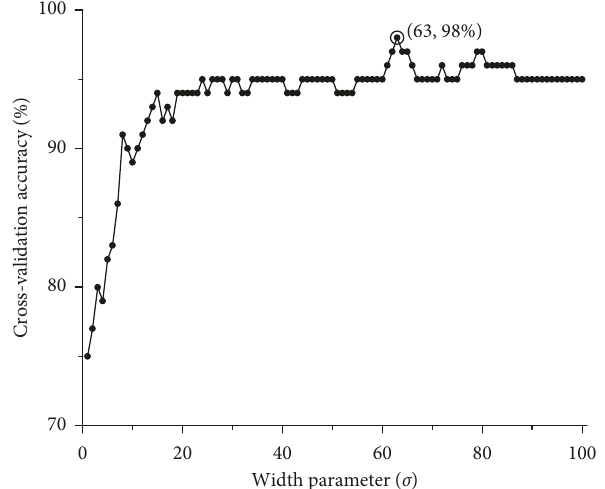
Figure 9: Process of determining the optimal parameter σ of GRB- KPCA: the variation trend of the maximum average PA of cate- gories of the validation set through GRB-KPCA-SVM with the change of σ .